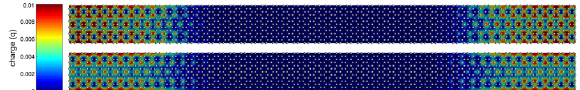
Fig. 8 Comparison of the charge distributions of the 13-AGNR- MOSFET using the WTB device Hamiltonian (above) and the produced TB device Hamiltonian (below). The gate voltage V GS is set to be 0 V, and the drain-source voltage V DS is set to be 0.2 V. The gray balls represent C atoms, whereas H atoms on the edges are not